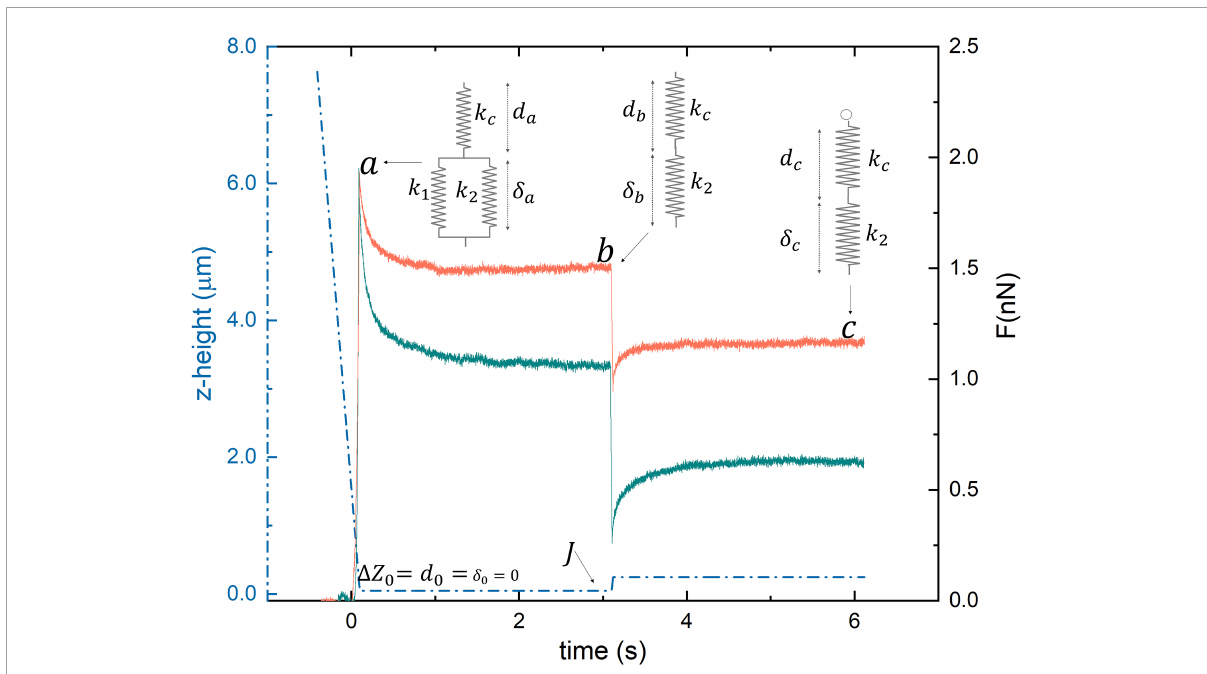
FIGURE2 Two representative loading/unloading time-dependent relaxation curves acquired on a healthy (orange) and pathological (cyan)